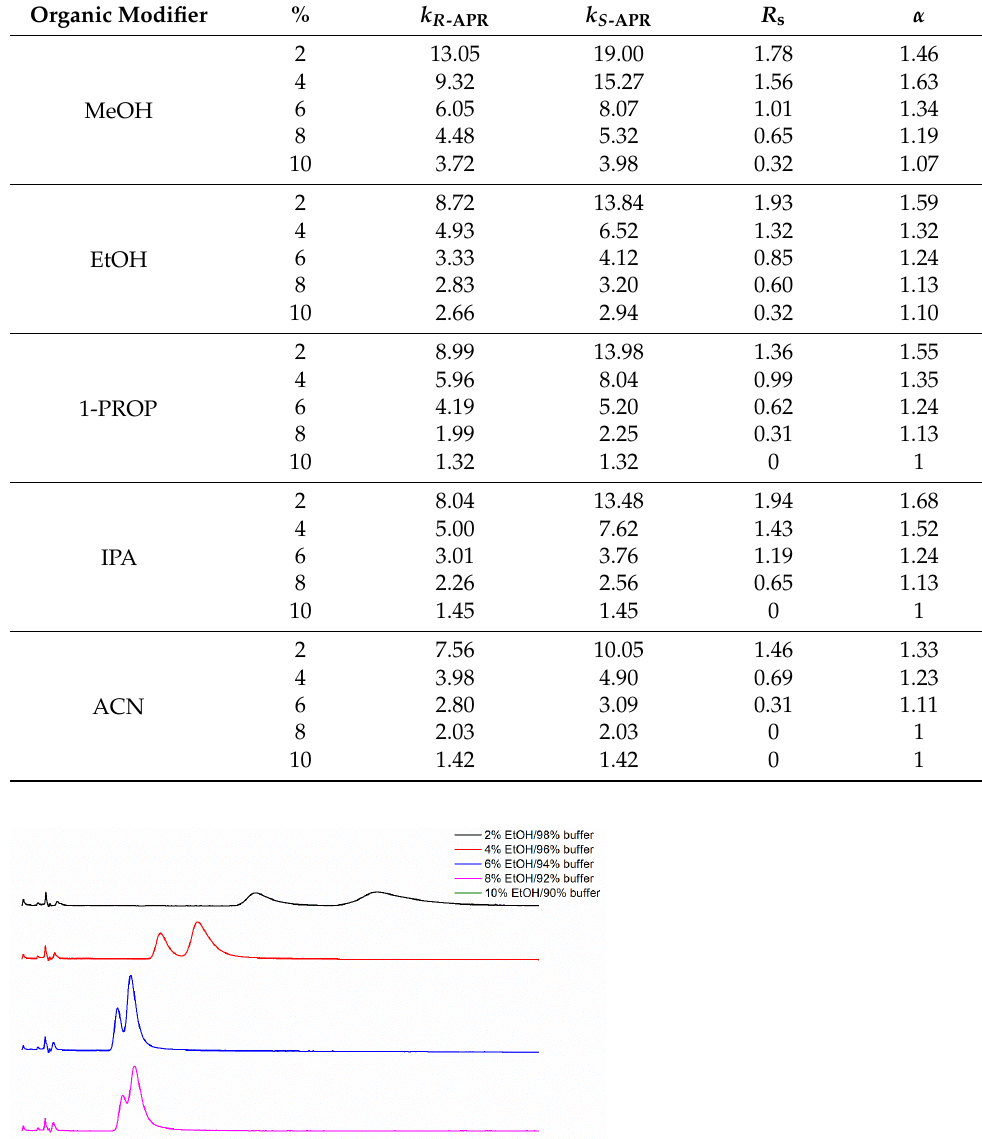
Table 1. Retention factors, resolutions and selectivity values in different percentages of five different organic modifiers on the Chiral-HSA column. Organic Modifier